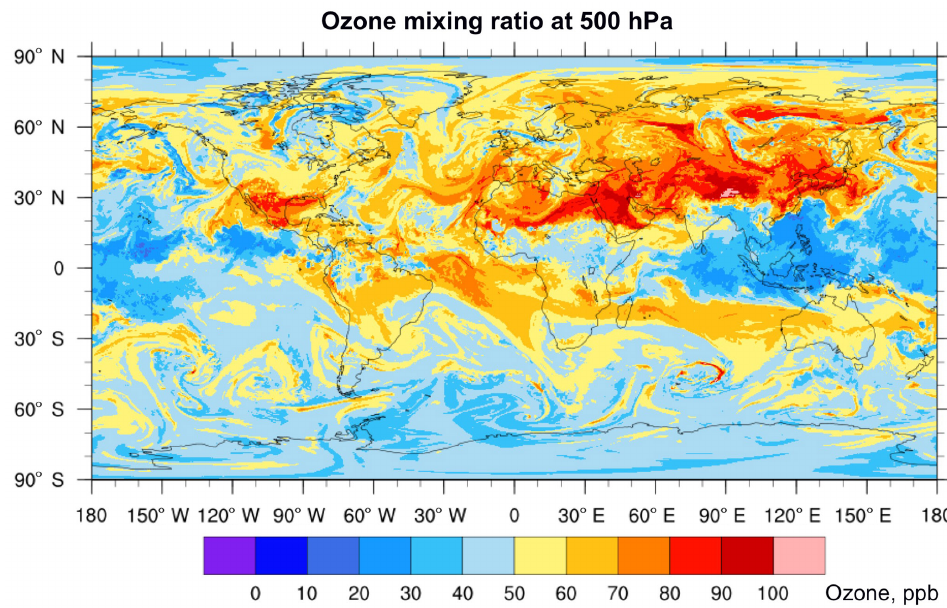
Figure 2. The 500hPa ozone distribution on 1 August 2013 at 00:00Z simulated by GEOS-5 with the GEOS-Chem chemical module at cubed-sphere c720 ( ∼ 12 . 5 × 12 . 5km 2 )